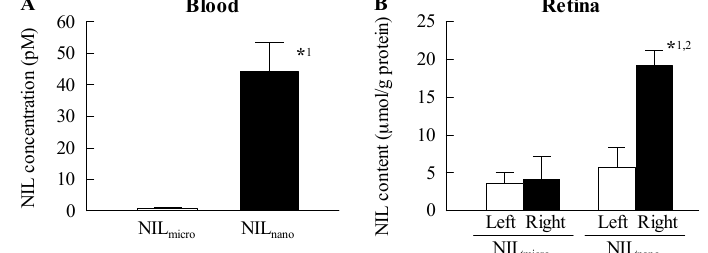
Figure 3. NIL concentrations in blood ( A ) and retina ( B ) of STZ rats instilled with NIL micro and NIL nano . NIL micro or NIL nano was instilled into the right eye of STZ rats, and 50 min later, the rats were killed, and the blood and the right and left retinas were collected. NIL micro , NIL micro -instilled STZ rats; NIL nano , NIL nano -instilled STZ rats. n = 5. * 1 p < 0.05, vs. NIL micro for each category. * 2 p < 0.05, vs. left retina (non-instilled eye) for each category. The NIL contents in retinas of rats instilled with NIL nano were locally enhanced.